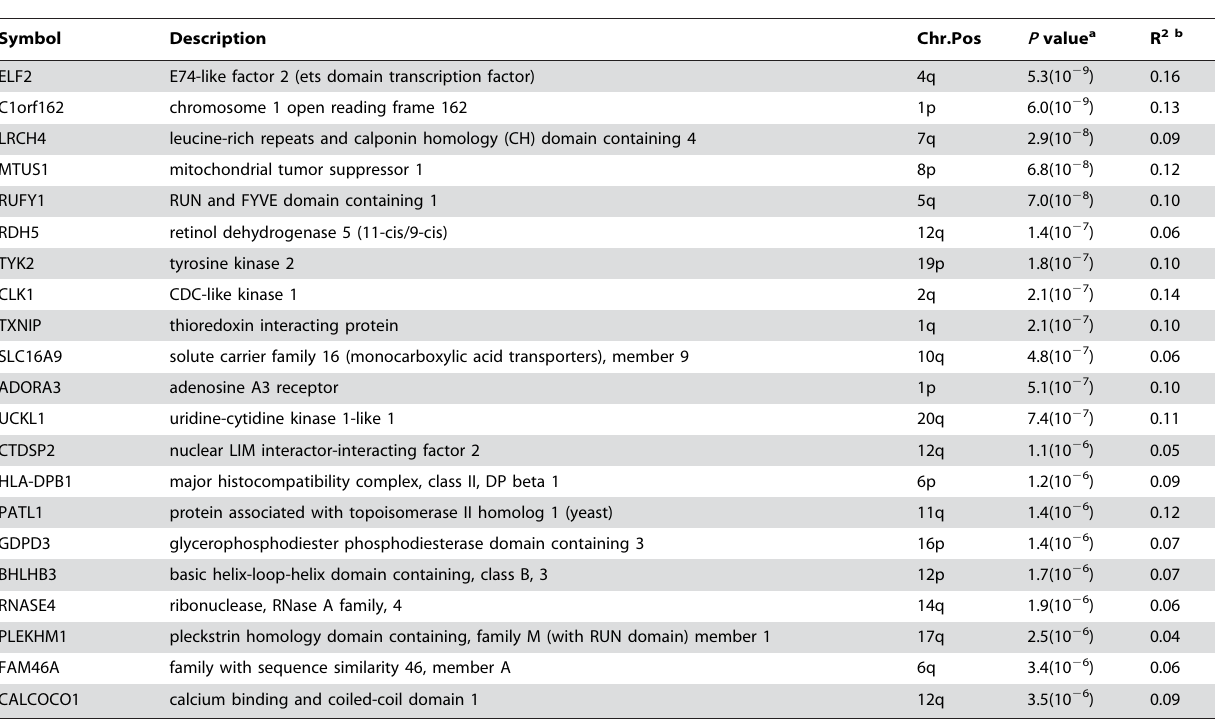
Table 2. Genes whose expression increases with age in the human brain.